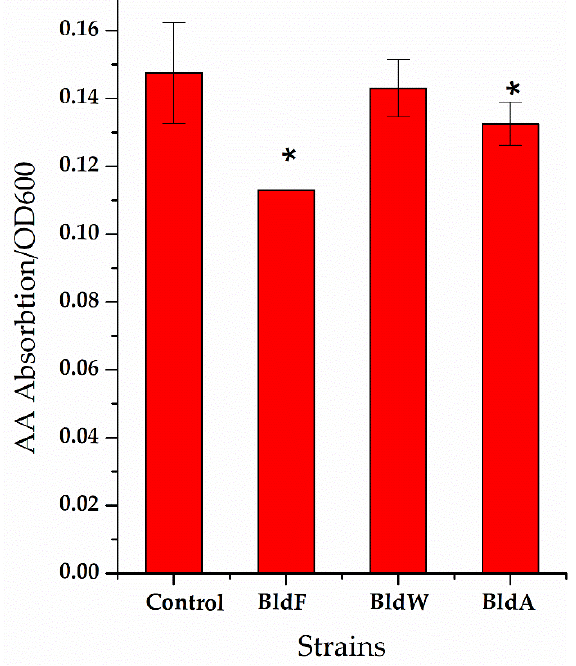
Figure 3. The ratio of the concentration of extracellular L-aspartic acid to the cell concentration of the strain lacking amino acid permease. A wild-type strain was used as a comparison. Each experiment was repeated at least three times; data are represented as the means of three replicates and bars represent the standard deviations. * p < 0.05 indicates the significance levels between recombinant strains and the control strain.